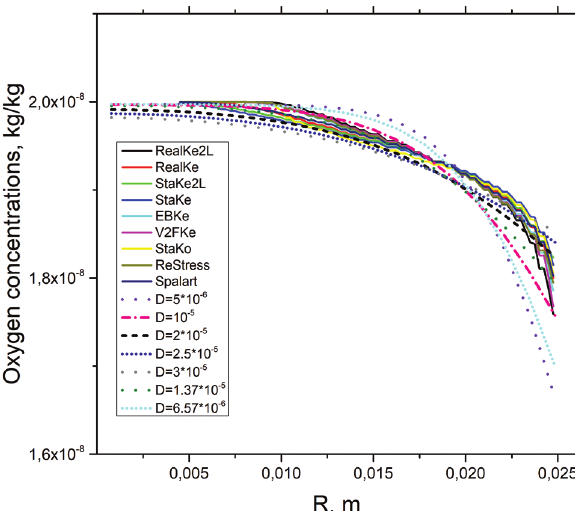
Figure 12. Distribution of oxygen dissolved in HLMC in the cross section of the pipe at Т = 400 °С.